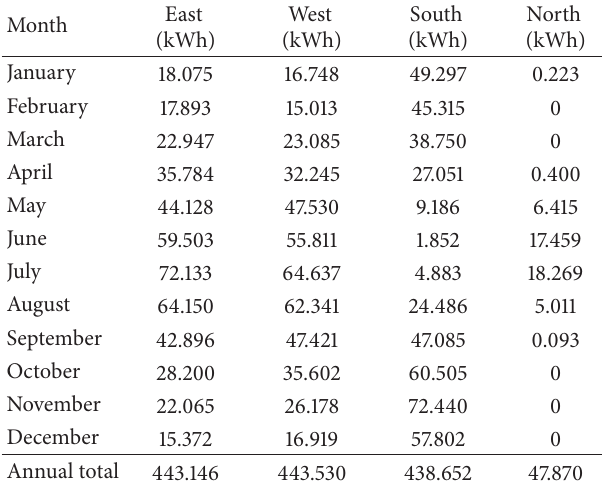
Table 5: Simulation results for monthly electrical power